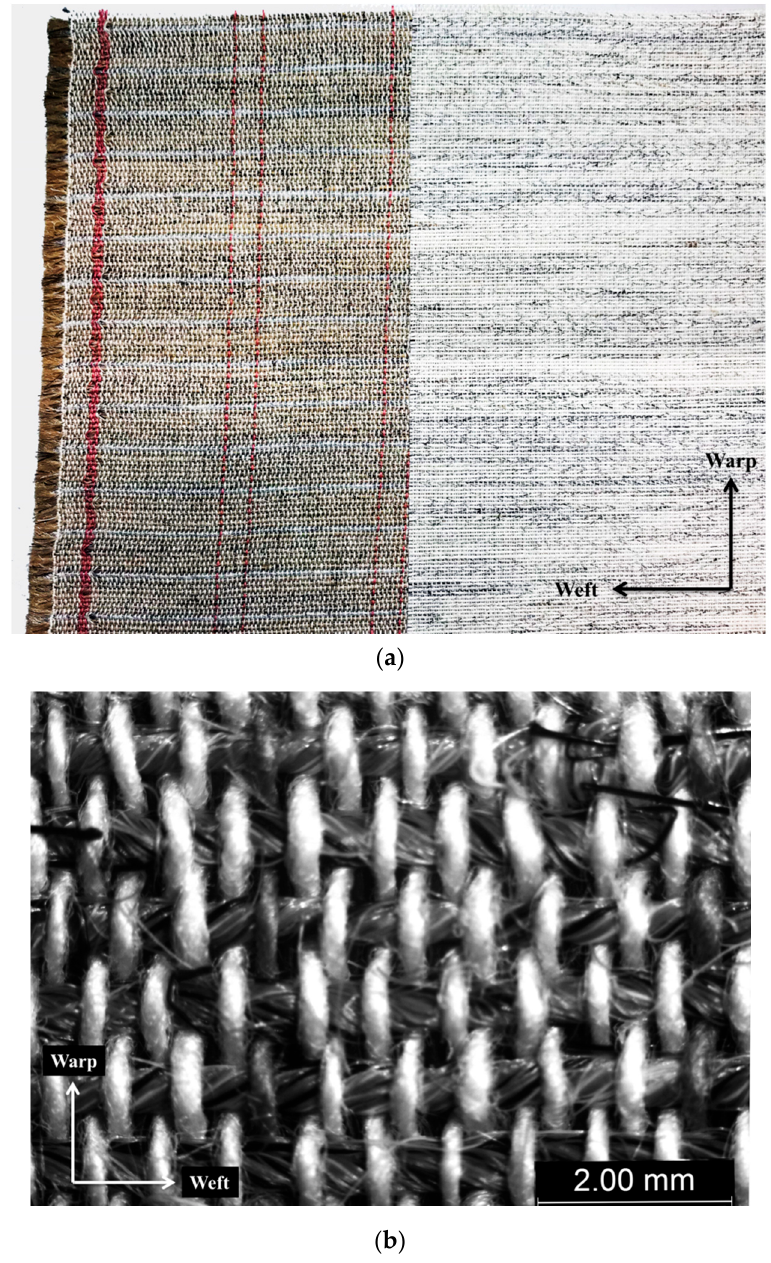
Figure 5. Hair interlinings ( a ) and Microscope Views of Hair Interlining ( b ).